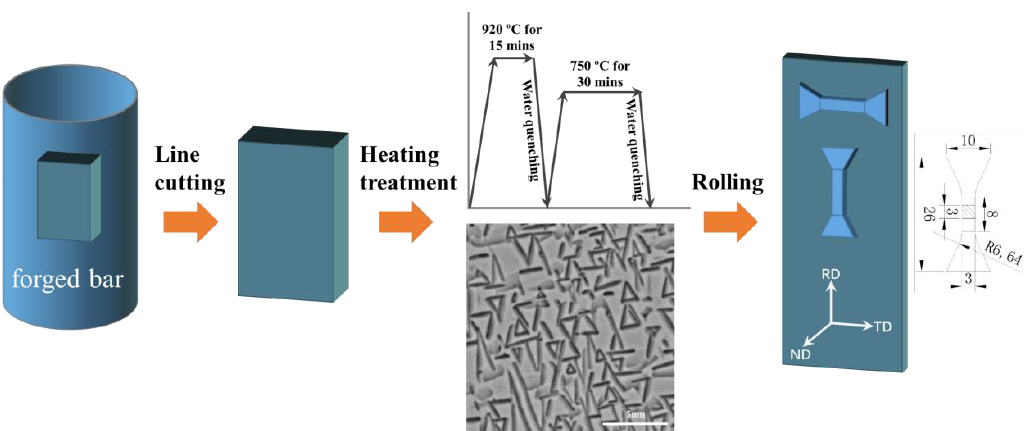
Figure 1. Line cutting and dimension of flat dog-bone-shaped tensile samples. RD = rolling direction; TD = transverse direction; ND = normal direction.